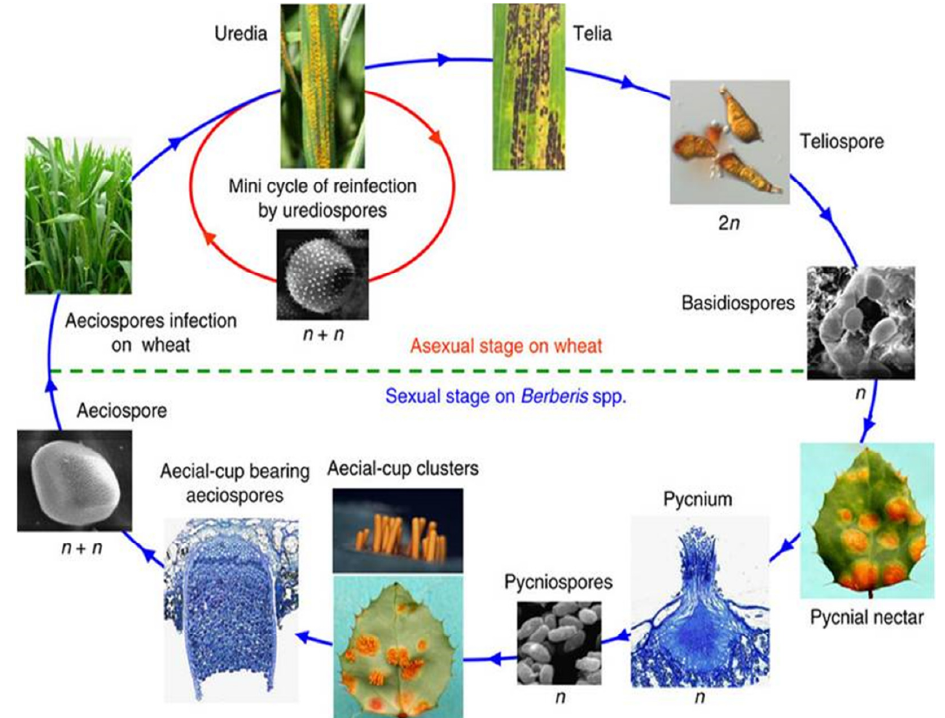
Fig. 2. The life cycle of Puccinia striformis f.sp. tritici (Zheng et al. ,